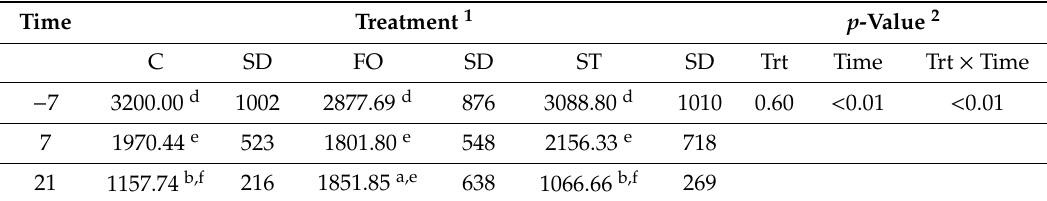
Table 1. Mean adipocyte area ( µ m 2 ) of subcutaneous adipose tissue of dairy goats fed with a basal